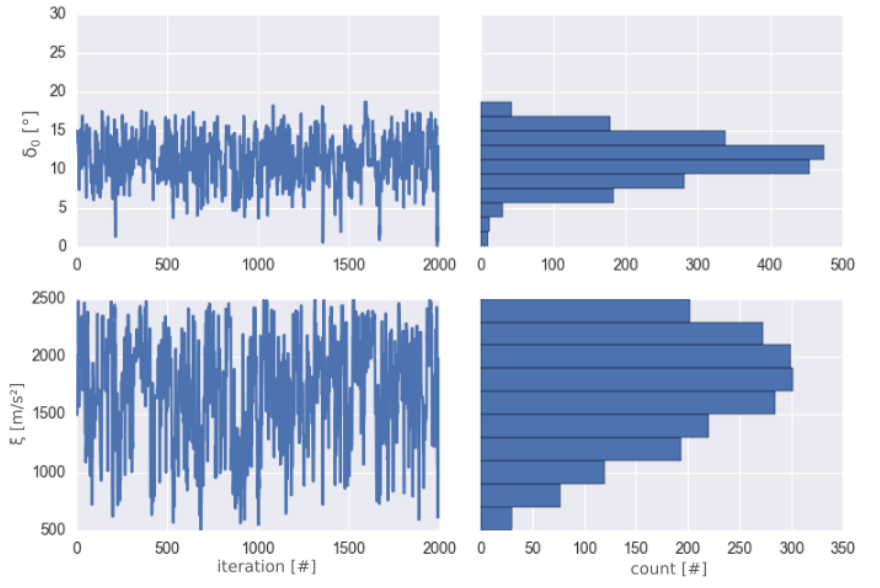
Figure 1. Trace plots and histograms showing parameter values for the 2000 iterations and total counts in the marginal posterior distribution θ post of the Markov chain. The trace plot indicates a good mixing for both parameters, which is reflected by the acceptance rate of 0.48 (967 elements of 2000). The candidates for δ 0 mainly concentrate around the mean value ¯ δ 0 = 11.3 ◦ , while observed ξ values span the entire parameter space around ¯ ξ = 1714 m s 2